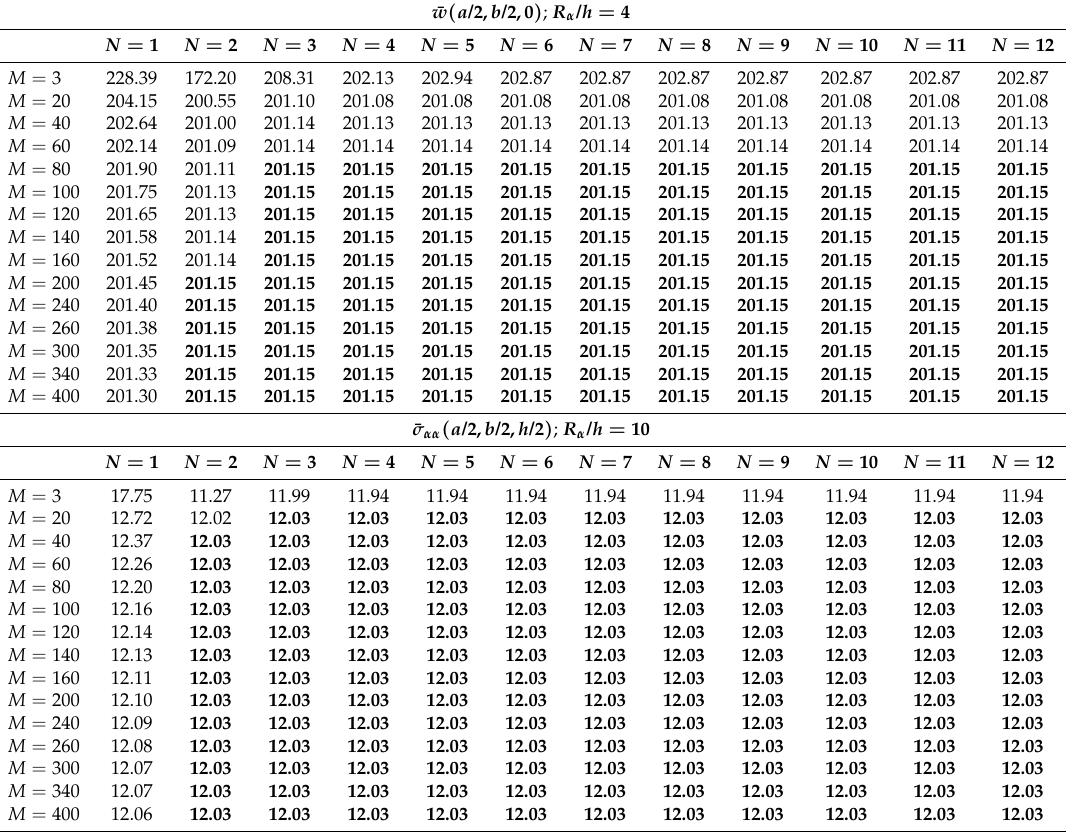
Figure 12. Case 4, sandwich spherical shell with FGM ( κ = 1) core and thickness ratio R α / h = 4. Displacement ¯ w ( a /2, b /2,0 ) vs. N order of expansion of the exponential matrix for different M numbers of global mathematical layers. Reference solution in Brischetto [23] is here indicated as REF. Table 4. Case 4, sandwich spherical shell with FGM ( κ = 1) core. Displacement ¯ w in the middle of the thickness for thickness ratio R α / h = 4 and stress ¯ σ αα at the top surface for thickness ratio R α / h = 10, both given as dimensionless values. Three physical layers ( N L = 3) divided into M global mathematical layers. 3D reference solution in Brischetto [23]. Digits given in bold are the correct